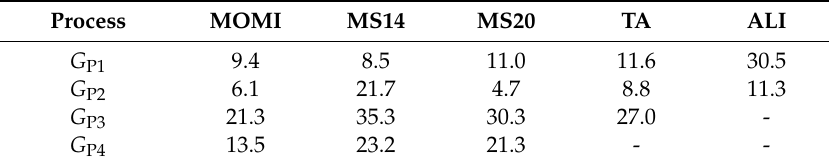
Table 6. The 5% settling times for reference